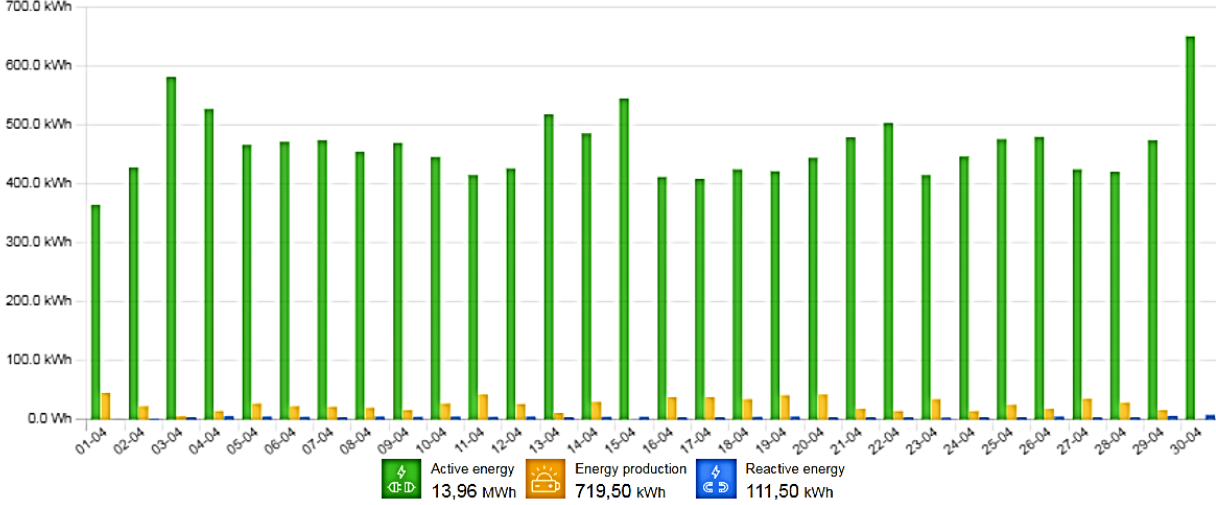
Figure 7. Energy flow in Sector 4 of the LSTP in April 2020, energy consumed (active energy), and energy fed into the grid (energy production).